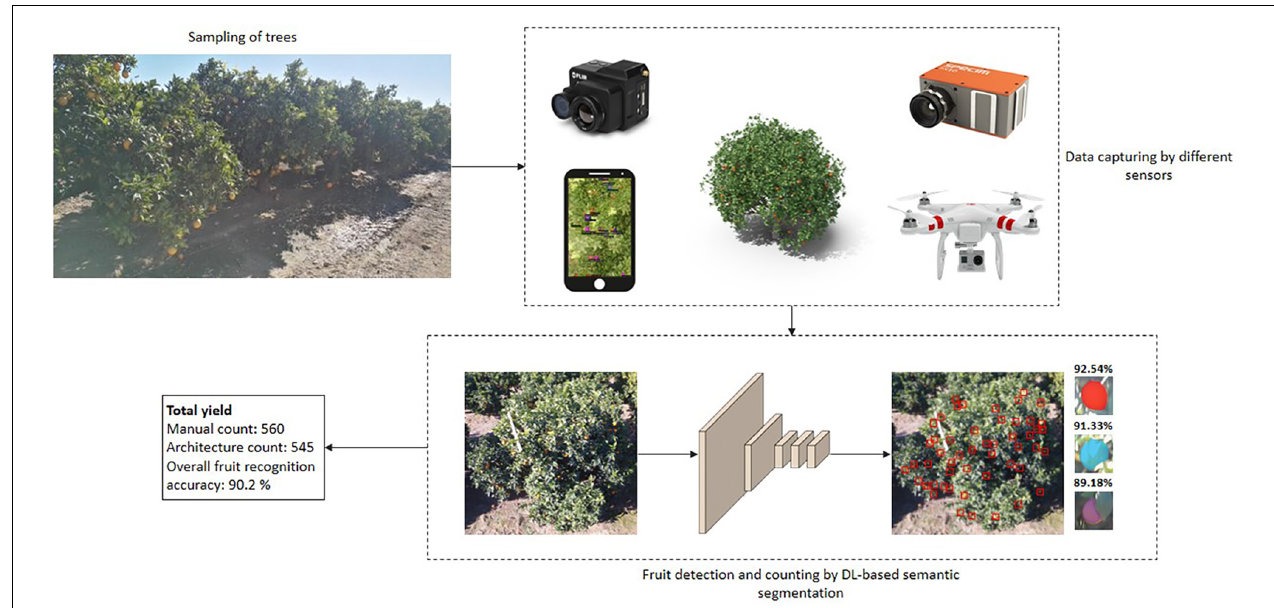
FIGURE 2 | Intelligent fruit yield estimation in